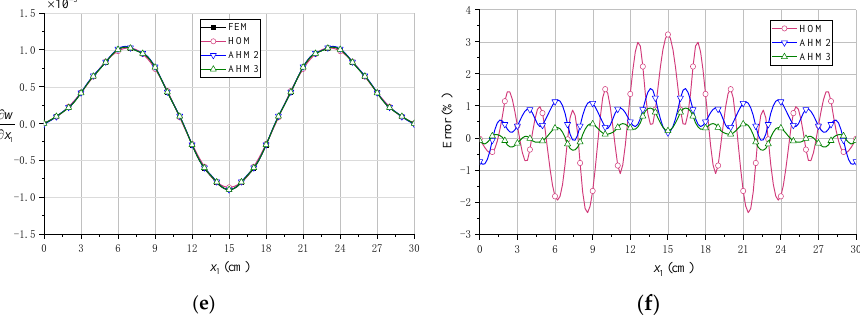
Figure 14. Deformations of the SFSF plate along Line A. ( a ) w ; ( b ) Error of w ; ( c ) ∂ w / ∂ x 2 ; ( d ) Error of ∂ w / ∂ x 2 ; ( e ) ∂ w / ∂ x 1 ; ( f ) Error of ∂ w / ∂ x 1 .